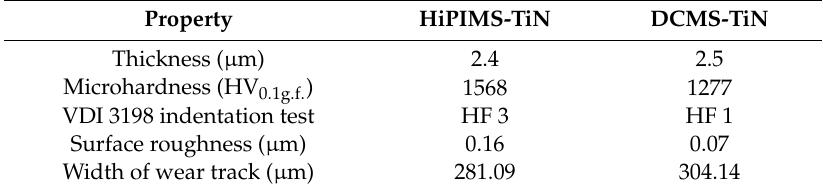
Table 4. Comparison of the mechanical properties of HiPIMS and DCMS TiN coated samples annealed at 300 ◦ C.